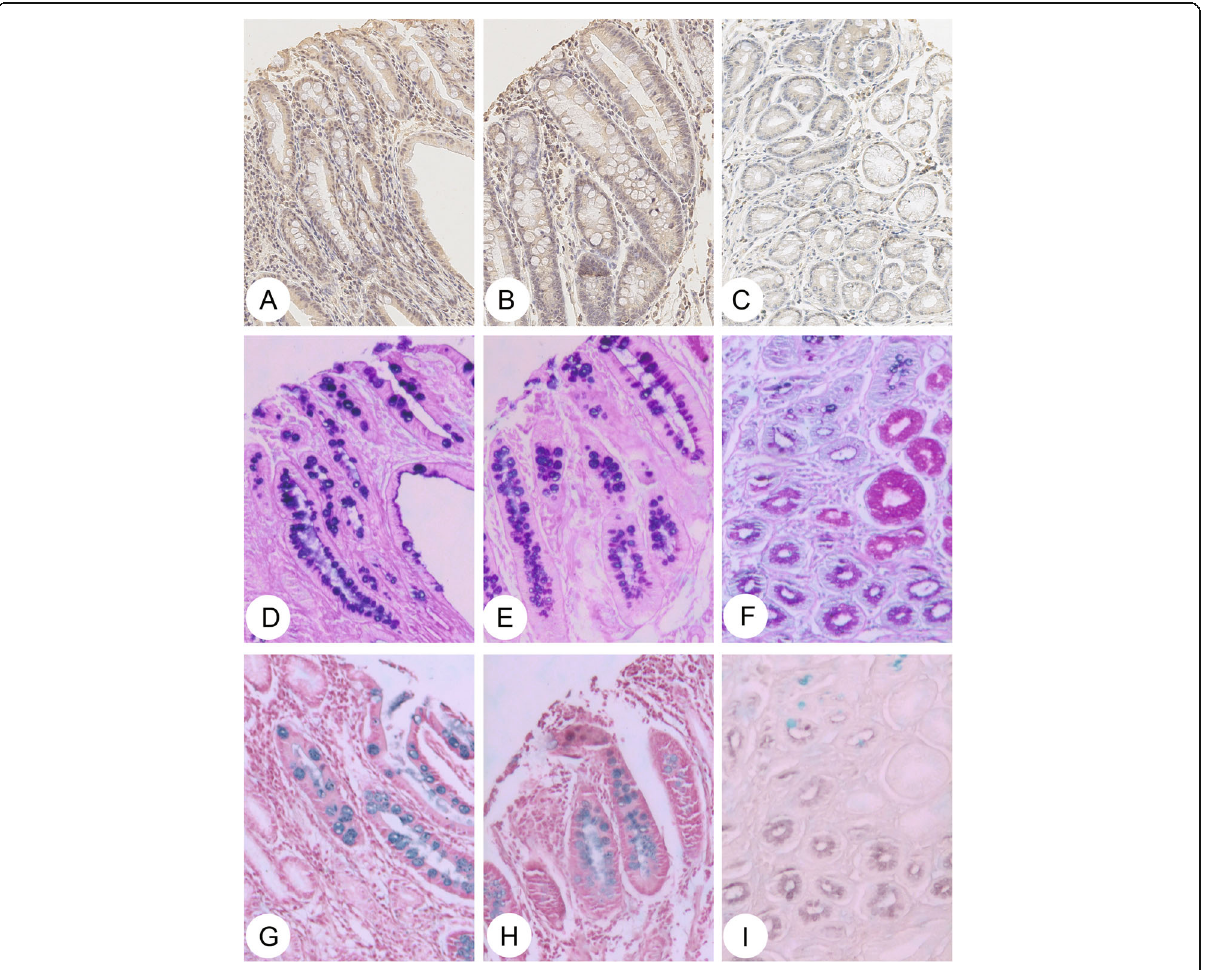
Fig. 1 GCRG213p expression and special acid stains in gastric intestinal metaplasia subtypes. Specific yellow-brown staining was identified in cytoplasm of the well-differentiated absorptive cells that have a brush-like border in IM cells. a , b , c with GCRG213p, a : type I; b : type II; c : type III; d , e , f with AB-PAS stains, d : type I; e : type II; f : type III; g , h , i with HID-AB stains, g : type I; h : type II; i : type